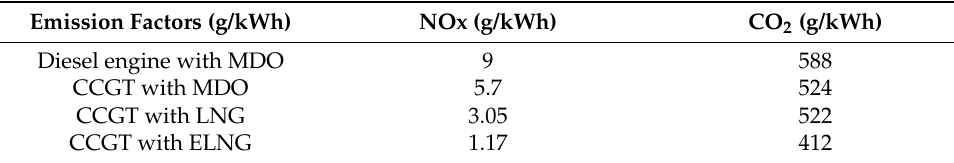
Table 5. Emissions factor for the CCGT and two-stroke diesel engines.